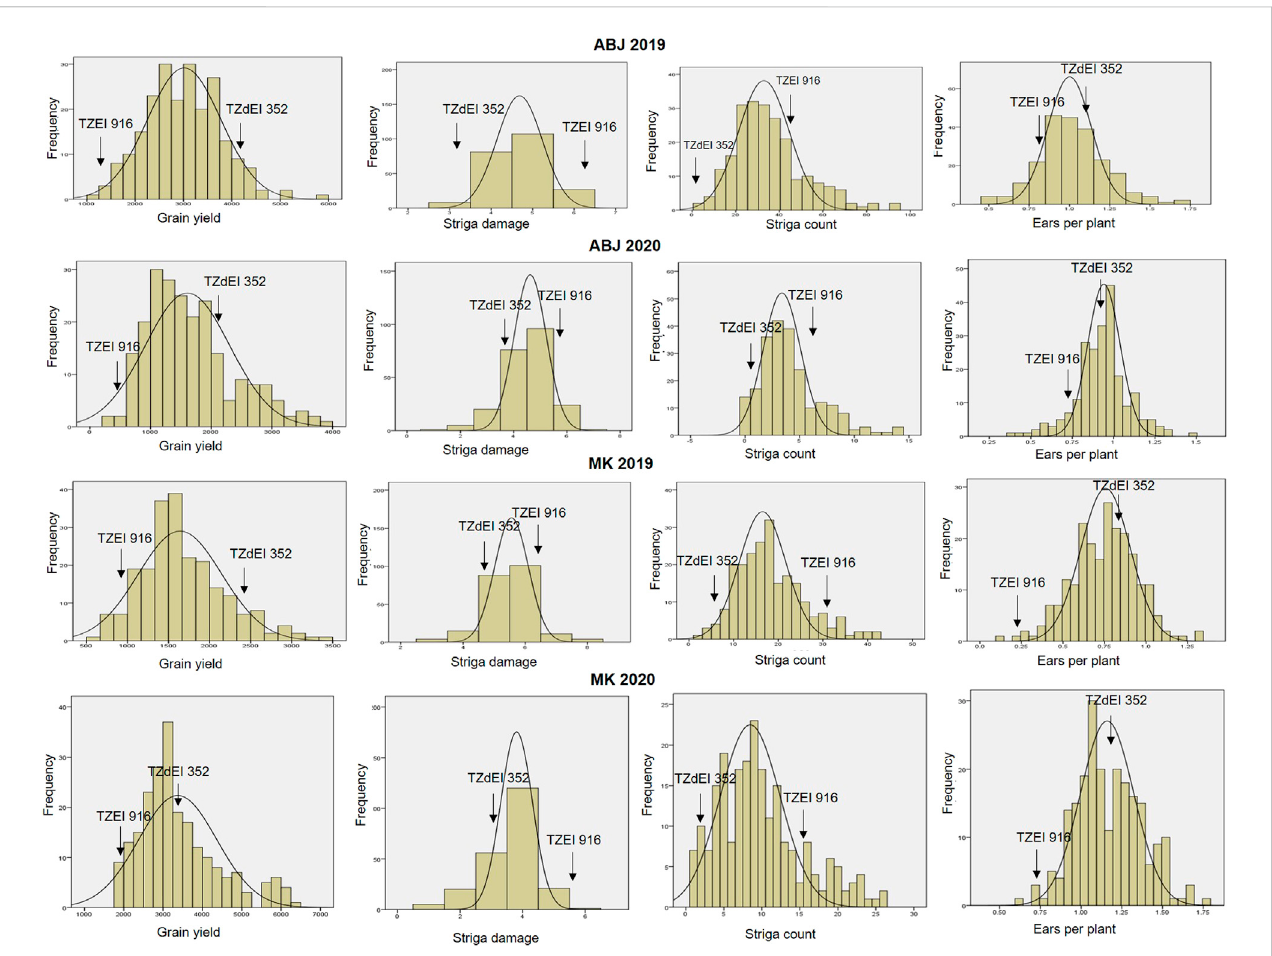
FIGURE 1 Frequency distribution of grain yield, number of ears per plant, Striga damage and number of emerged Striga plants among the F 2:3 mapping population individuals, 2019 – 2020. ABJ — Abuja, MK — Mokwa.